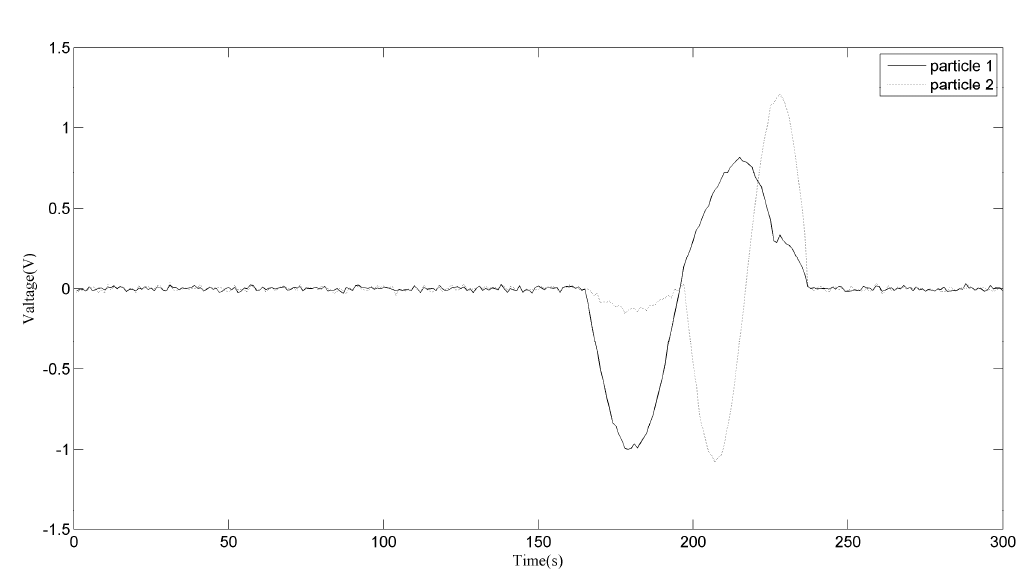
Figure 8. Clustering result of section a1.